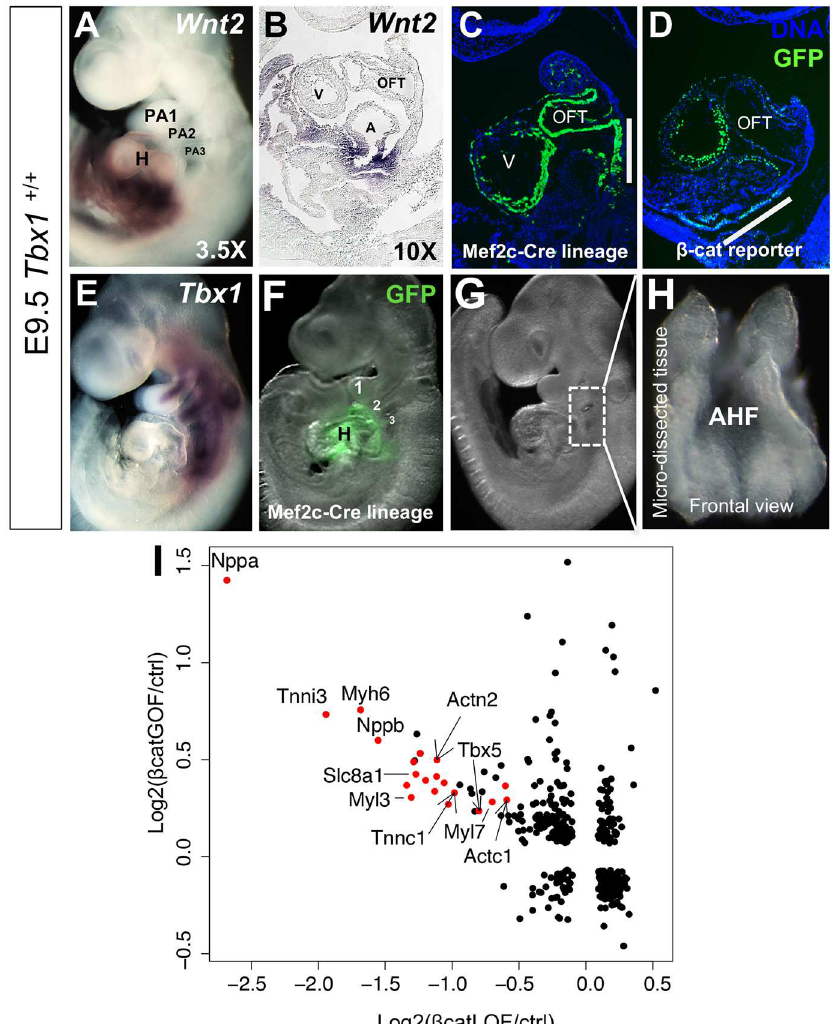
Fig 1. Constitutive β -catenin expressionin the AHF promotes differentiation. (A) Whole mount in situ hybridization (WMISH) of Wnt2 in a wild type ( Tbx1 +/+ ) embryo at embryonic day 9.5 (E9.5) and a sagittal section from the heart regionof the embryo is shown in B. (C) Mef2c-AHF-Cre lineagein a wild type embryo in a sagittal section. (D) Visualization of β -catenin signalingusing a TCF/Lef : H2B-GFP reporter allelein a sagittal section of a wild type embryo. (E) WMISH of Tbx1 in a wild type embryo. (F) Mef2c-AHF-Cre lineage shown by green fluorescence in a wild type embryo ( Mef2c-AHF-Cre/+;ROSA26- GFP f/+ ) at E9.5. Numbers denotethe pharyngealarches 1, 2 and 3. (G) Whole mount embryo showing the regionthat has been dissected for the experiments (rectanglein dorsal to the heart). (H) The micro-dissected regioncontaining the Mef2c-AHF-Cre lineageis shownfrom a frontal view. (I) Comparisonof globalgeneexpressionchangesin micro-dissected tissues of β -cateninGOF and β -cateninLOF embryosat E9.5. Differentially expressedgenes (p < 0.05 and FC > 1.5) in at least one of the two comparisons, β -cateninLOF vs control (x-axis) or β -catenin GOF vs control (y-axis), were plotted. Red dots denote cardiacdifferentiationgenes. Abbreviations: heart (H), pharyngeal arch (PA), outflow tract (OFT), ventricle(V), atrium (A), FC = fold